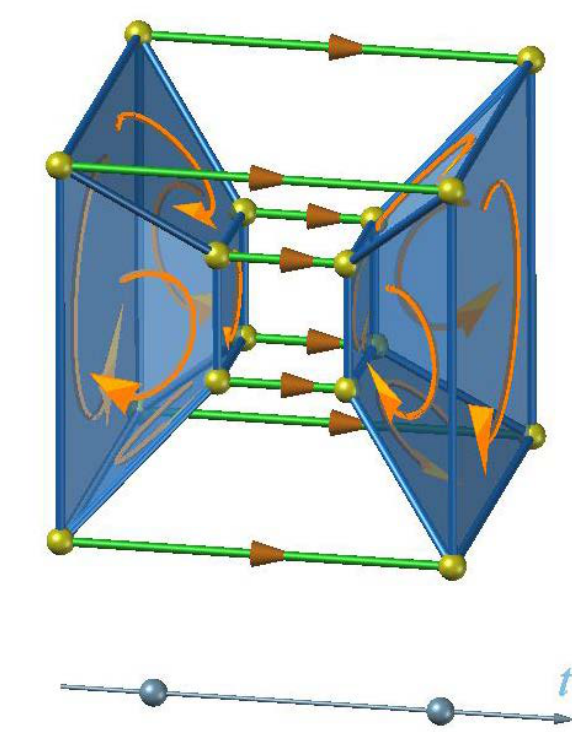
Figure 70: The CM tesseract: inner orientations on the 3-cells of the kind space and the 1-cells of the kind